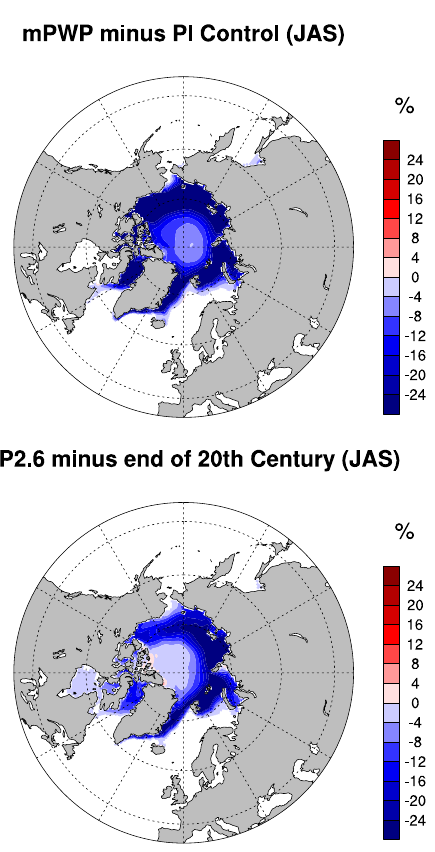
Fig. 12. Spatial maps of the change in NH JAS sea ice area (%) in the mPWP simulation (mPWP minus PI control) (top). Change in NH JAS sea ice area (%) in the IPCC RCP2.6 scenario